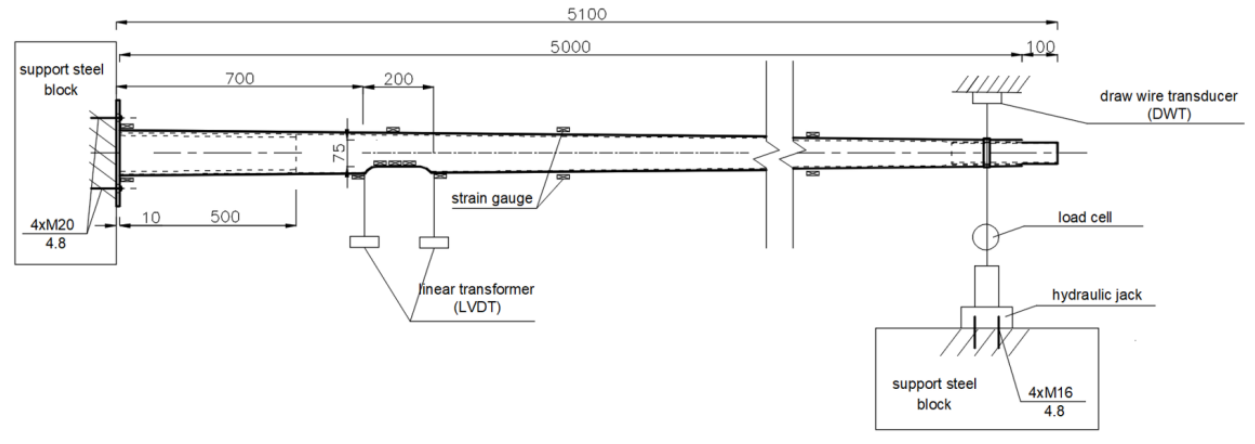
Figure 3. Full-scale test setup for 5 m poles.